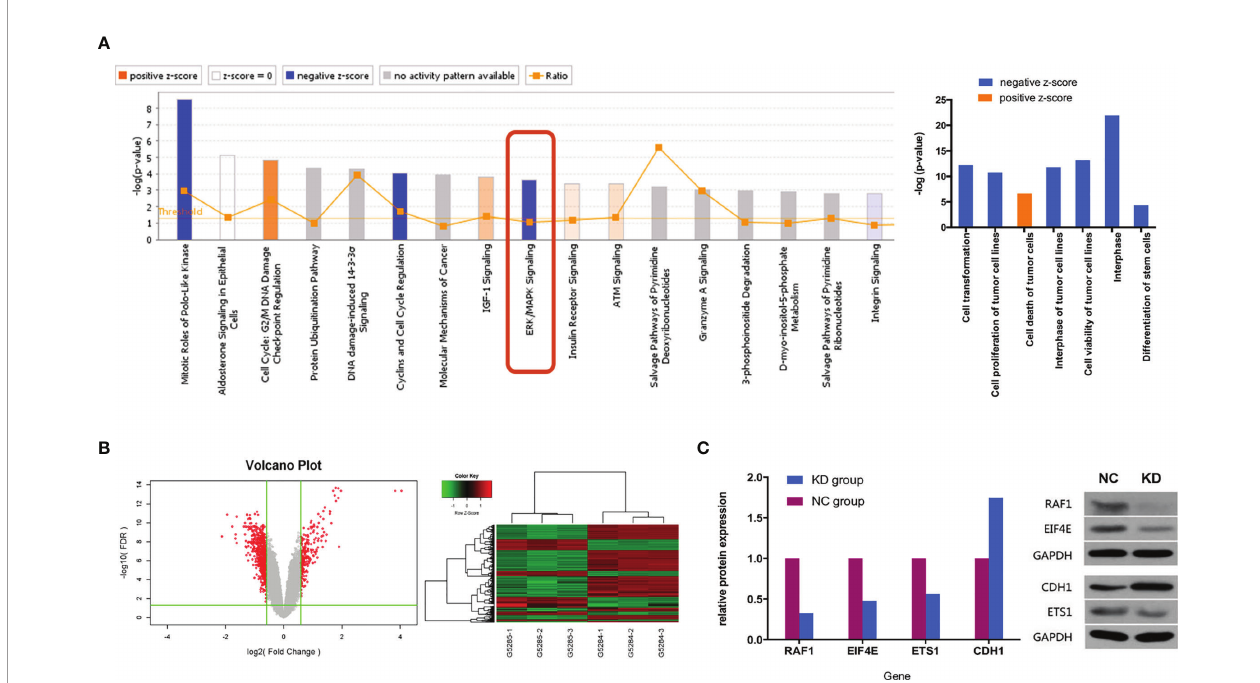
FIGURE 4 | (A) Classic pathway enrichment analysis and disease and function analysis based on IPA by GeneChip PrimeView. Our experiments suggested that when CX3CL1 is inhibited, the ERK/MAPK signaling pathway is inhibited, the function of promoting tumor growth is inhibited, and tumor death is enhanced. (B) Chip volcano plot (left) and hierarchical clustering (right): in the volcano plot, the abscissa represents the multiple of the gene expression difference (transformed by log2), the ordinate represents the signi fi cant FDR of the difference (transformed by log10), the red dots were selected with |Fold Change|>1.5 and FDR<0.05 as the screening criteria for genes that were signi fi cantly differentially expressed, and the gray dots are other genes that were not signi fi cantly differentially expressed; in the hierarchical clustering data, red means that gene expression was relatively upregulated, green means that gene expression was relatively downregulated, black means that the degree of gene expression did not change signi fi cantly, and gray means that the signal intensity of the gene was not detected. (C) Relative expression of downstream genes and proteins in the ERK/MAPK signaling pathway between NC and KD cells (Western blot). NC, normal control group; KD, CX3CL1 gene knockdown